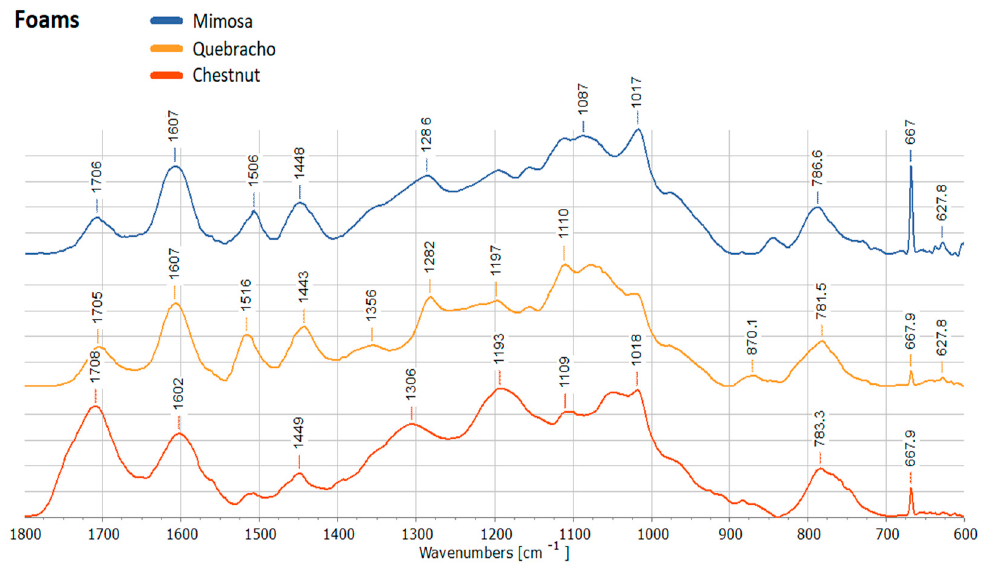
Figure 8. ATR FT-IR spectra of the mimosa, quebracho and chestnut-based tannin foams.